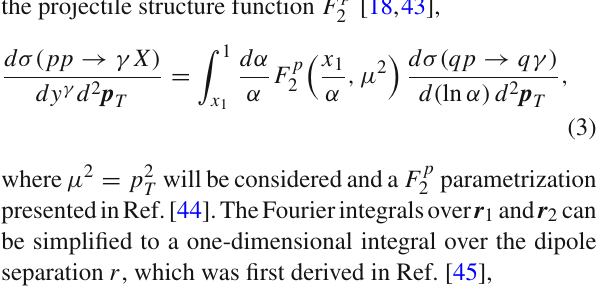
Fig. 1 Typical diagrams for real photon bremsstrahlung by a quark (antiquark) interacting with the target via gluon exchange. The photon radiation may happen either before (left panel) or after (right panel) the quark-target scattering